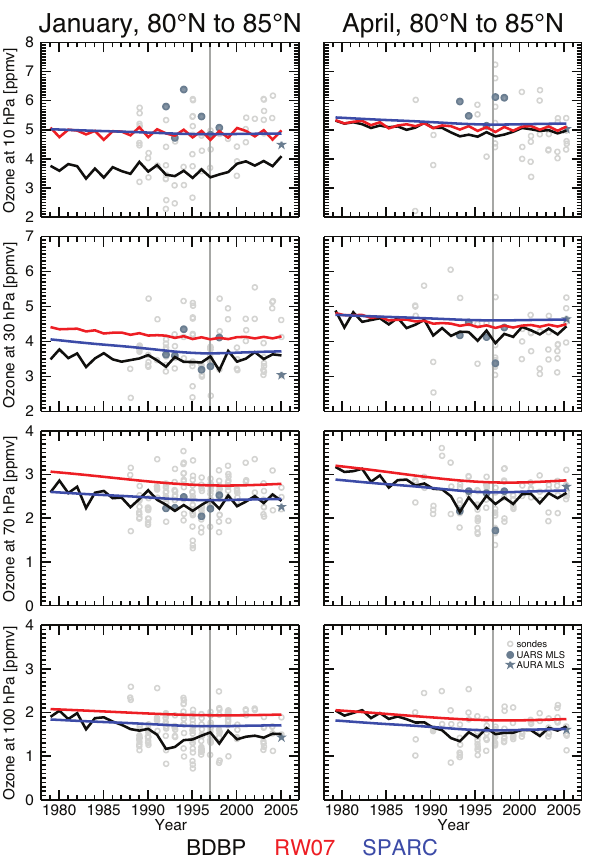
Fig. 4. January (left) and April (right) ozone time series 80 ◦ N to 85 ◦ N for four different pressure levels. Individual ozonesonde measurements available in this zone are shown for these months (grey open circles), together with UARS MLS monthly means (dark grey, filled circles) and AURA MLS monthly means (dark grey, filled stars), and the BDBP (black), RW07 (red) and SPARC (blue) time series. The vertical grey line denotes the inflection point selected for piecewise linear trend calculations (see Section 6).